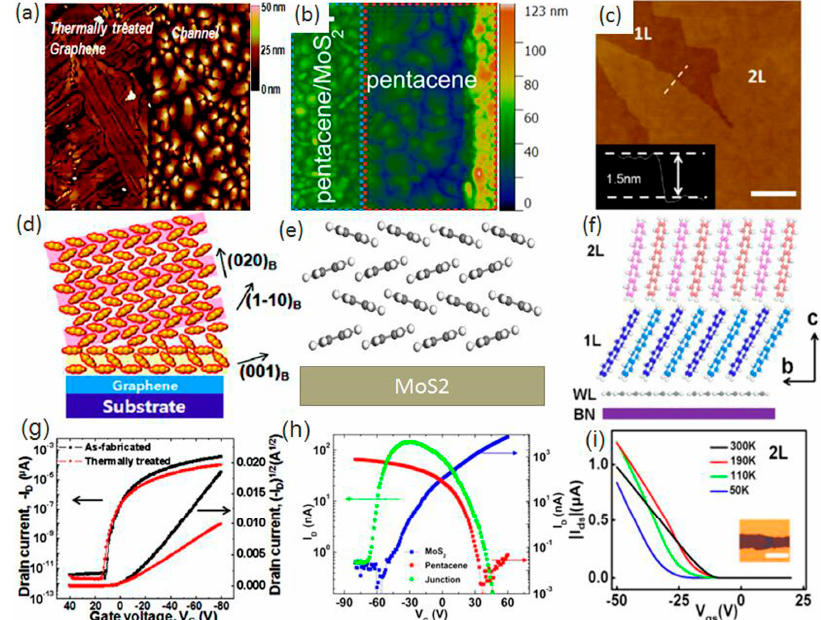
Figure 3. Epitaxial growth of pentacene molecular crystals on layered substrates. ( a ) AFM image of ~50 nm thick pentacene films over the sharp linear boundary between G-covered and bare SiO 2 . ( b ) Forty nanometer pentacene films over the boundary between MoS 2 -covered and bare SiO 2 . ( c ) Approximately two ML pentacene crystals with a flat-lying wetting layer on mechanically exfoliated h -BN. ( d – f ) Schematic illustrations of the molecular packing of ( a – c ), respectively. ( g – i ) The